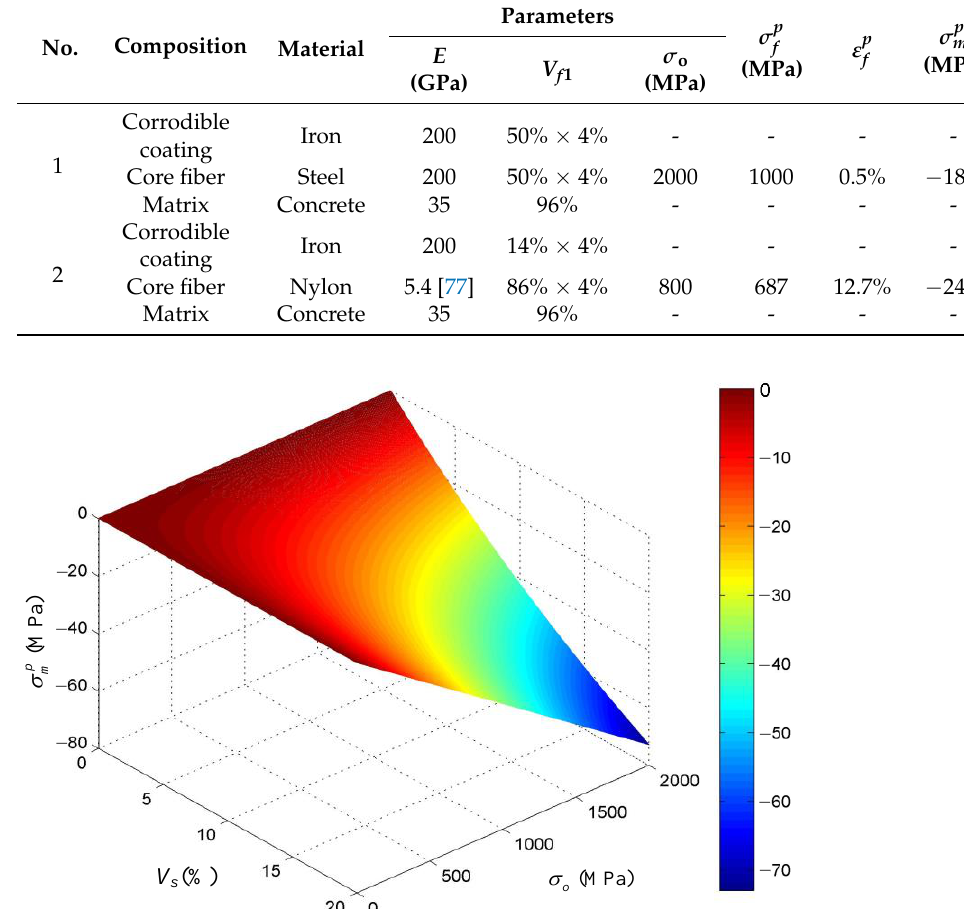
Figure 5. The influence of the amount of CIFs ( V s ) and the initial tensile stress ( 𝜎 0 ) on the maximum pre-stress released to concrete ( 𝜎 𝑚𝑝 ).